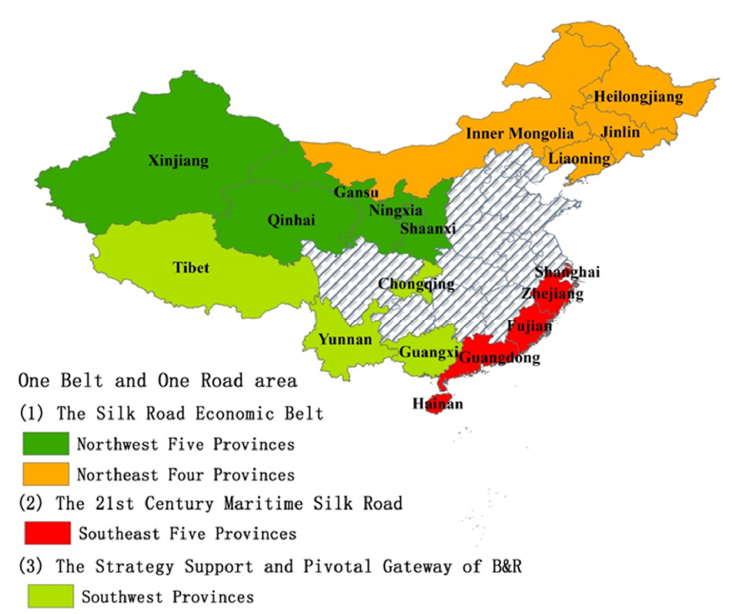
Figure 1. One Belt and One Road region’s 18 provinces and municipalities in China.